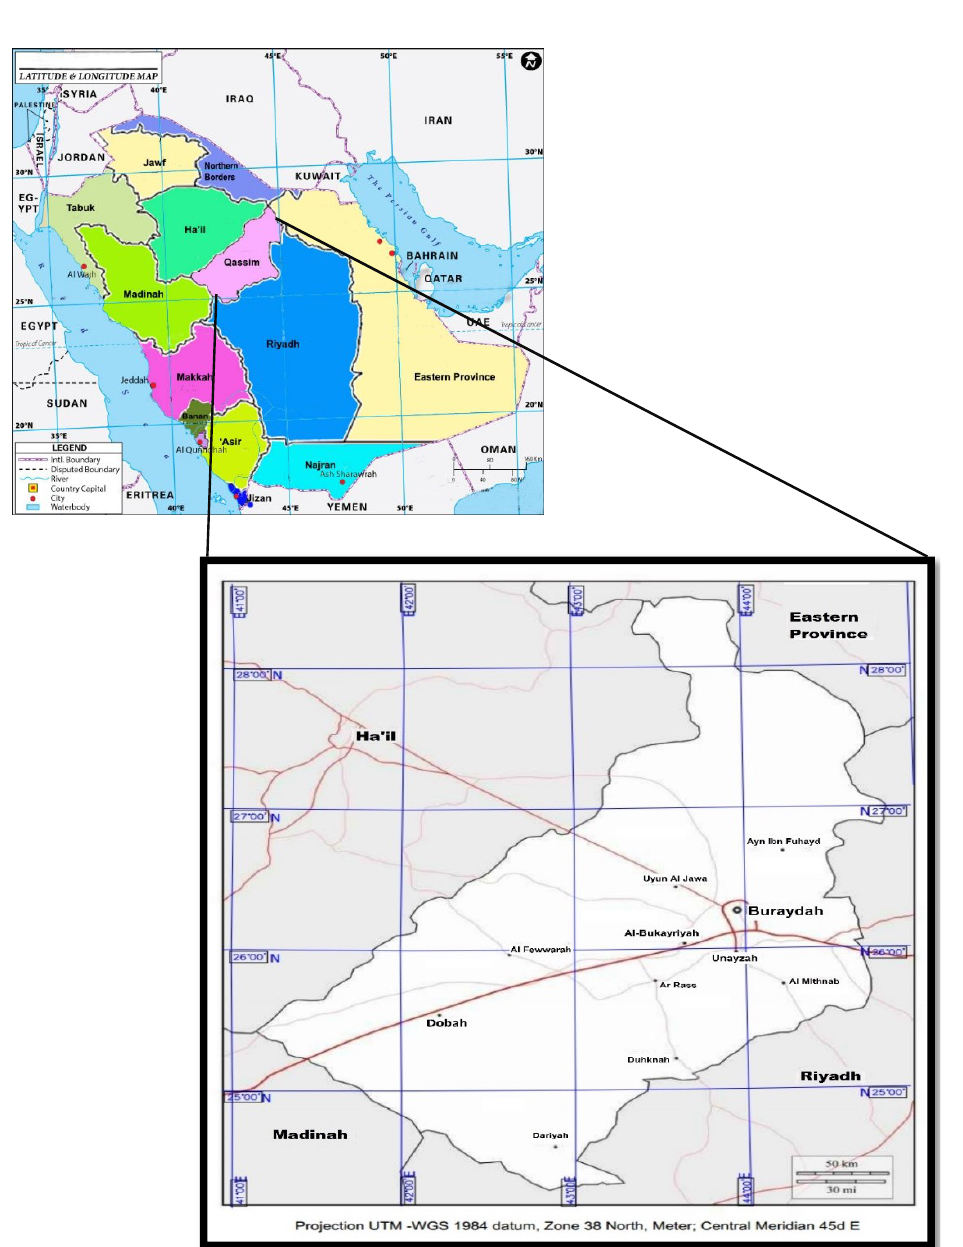
Figure 2. Map showing the location of the Qassim region in the Kingdome of Saudi Arabia.